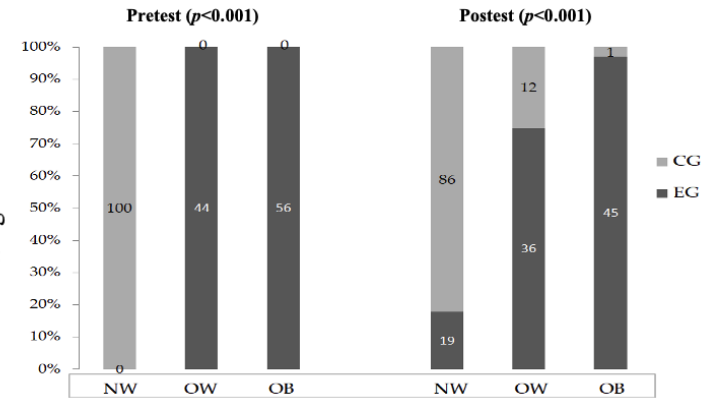
Figure 2. Weight status before (pre-test) and after (post-test) training program. EG: experimental group; CG: control group; NW: normoweight; OW: overweight; OB: obese.